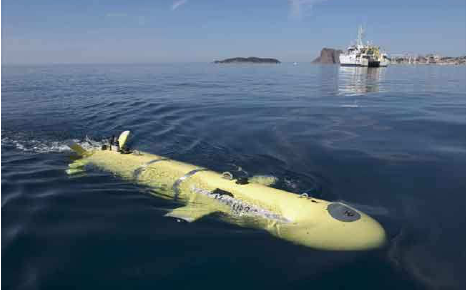
Figure 3: The Autonomous Underwater Vehicle AsterX of the French Research Institute for Exploitation of the Sea (IFRE- MER). (source: